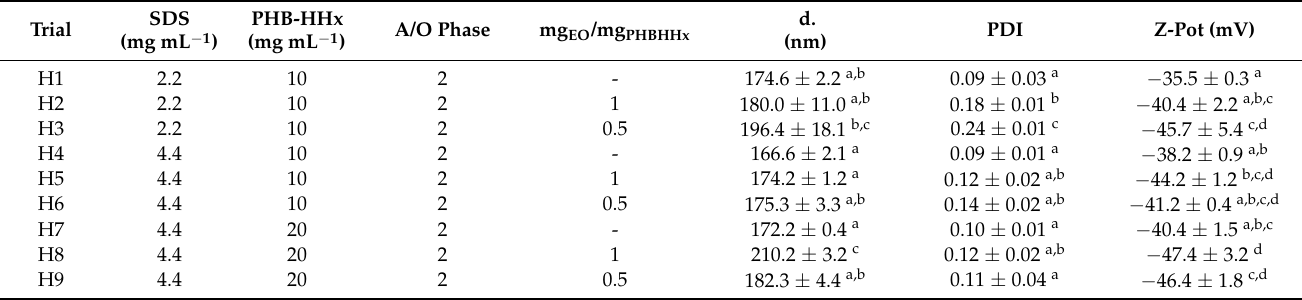
Figure 1. Effect of PHB polymer concentration and mg EO /mg Polymer ratio ( w / w ) on Encapsulation efficiency, EE%, and Loading capacity, LC%. S10, S11, S13 and S14 correspond to samples reported in Table 1 (Means that do not share a letter are significantly different). Table 2. Effect of different parameters on the synthesis of PHB-HHx-based nanoparticles. A/O, Aqueous/Organic phase volume ratio, PDI, polydispersity index, d., diameter. Values are mean ± SD; the different letters indicate significant differences from the values reported in the same column (Tukey–Kramer test, p < 0.05). The different letters indicate significant